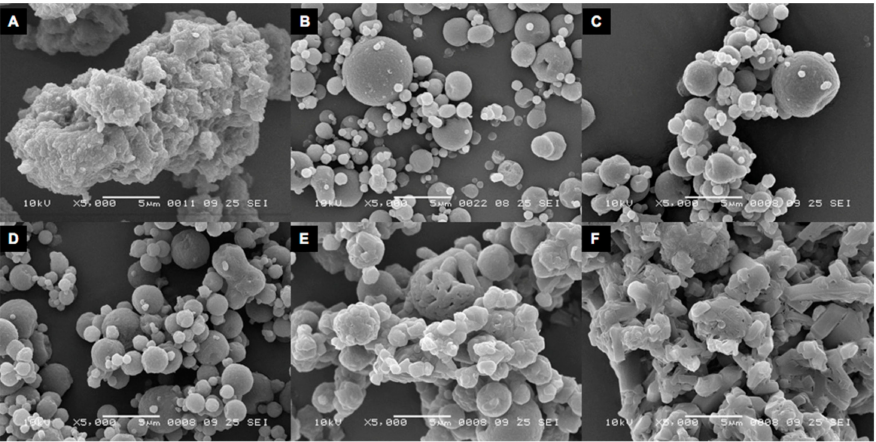
Figure 9. Scanning electron microscopy images of spray-dried isoniazid. ( A ) shows pure spray-dried isoniazid. ( B ) spray-dried isoniazid with 5% l -leucine directly after spray drying. ( C – F ) show samples stored for two days at 0%, 58%, 75%, and 90% RH, respectively. Magnification: 5000 ×